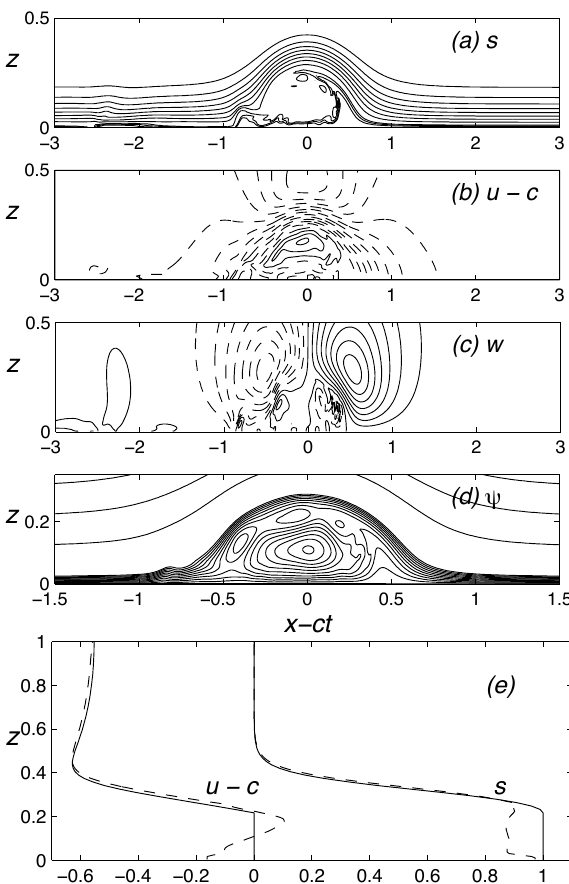
Fig. 16. Scatterplot of the core vorticity versus streamfunction for the wave in Fig.